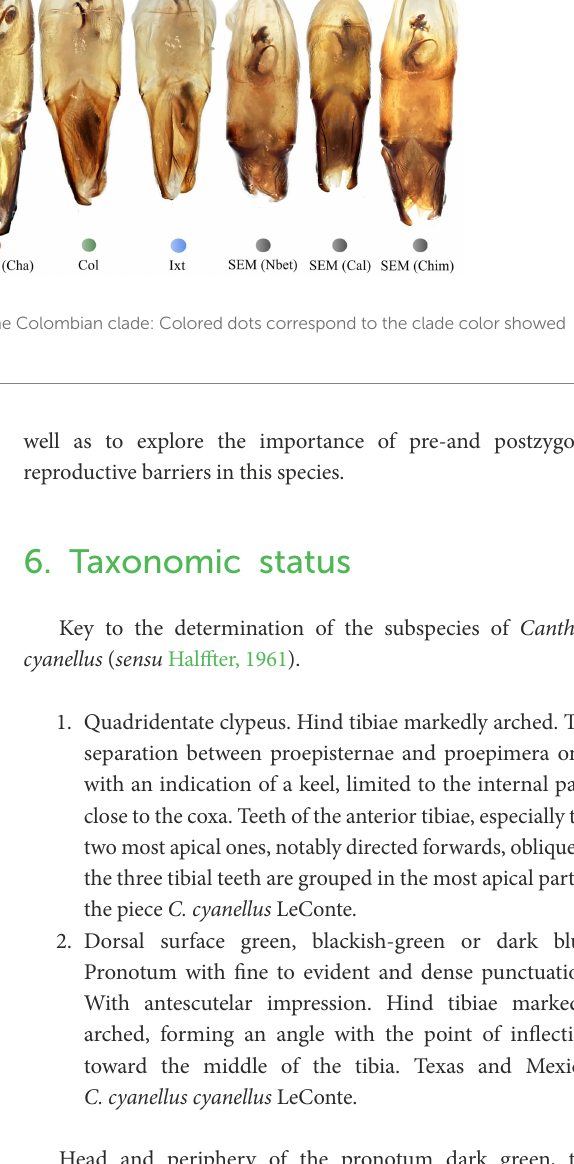
FIGURE 6 Aedeagus dorsal